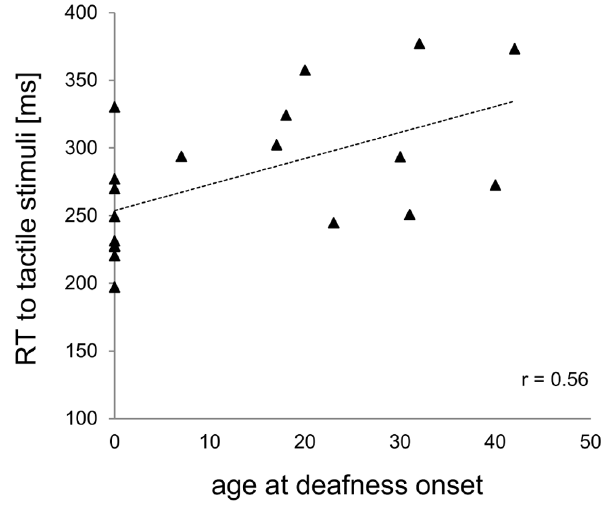
Figure 2. Correlation between unisensory tactile stimuli and age at deafness onset. Reaction times (in ms) to unisensory tactile stimuli as a function of age at deafness onset (in years).